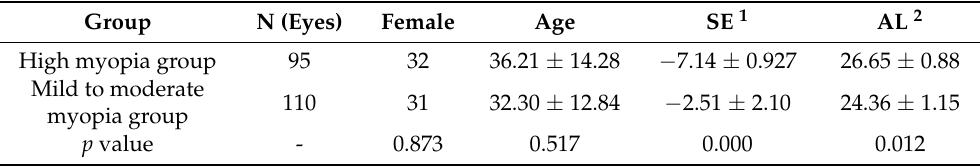
Table 1. Baseline characteristics of the included participants.